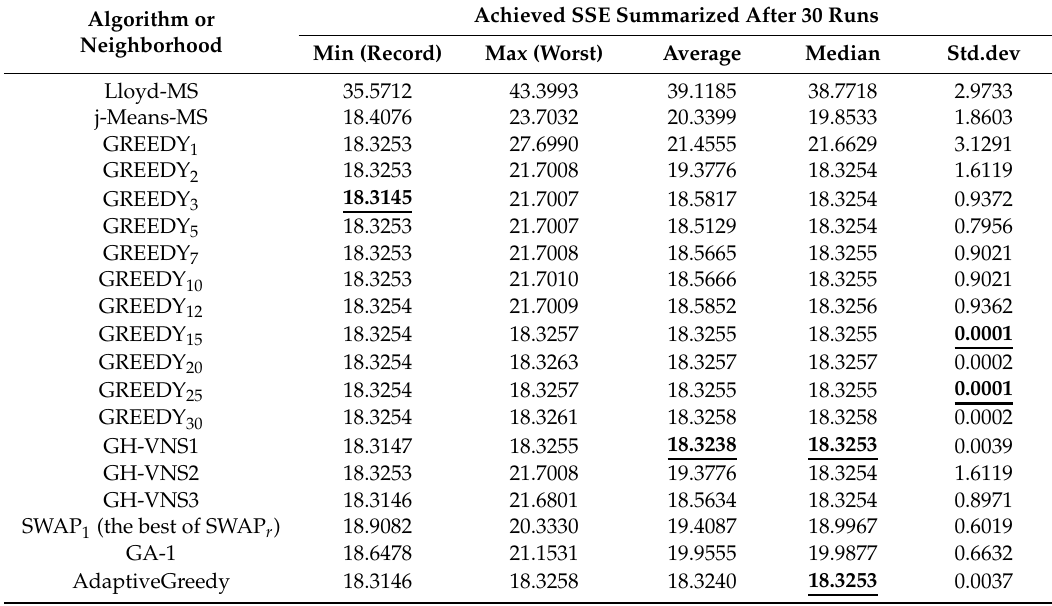
Table A1. Comparative results for Mopsi-Joensuu data set. 6014 data vectors in R 2 , k = 30 clusters, time limitation 5 s.